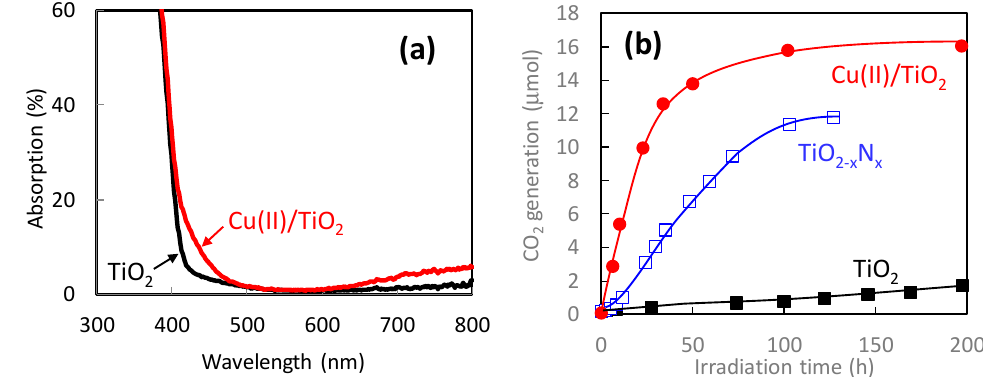
Figure 7. ( a ) Optical absorption spectra of TiO 2 (black line) and Cu(II) / TiO 2 (red line). Amount of Cu(II) was 0.1 wt% versus TiO 2 particles. ( b ) Photocatalytic oxidation activities of 2-propanol under visible-light irradiation for bare TiO 2 (black), TiO 2-x N x (blue), and Cu(II) / TiO 2 (red). Visible-light irradiation was conducted using a xenon lamp passed through optical filters to set the wavelength at 400–530 nm with an illuminance of 1 mW / cm 2 .